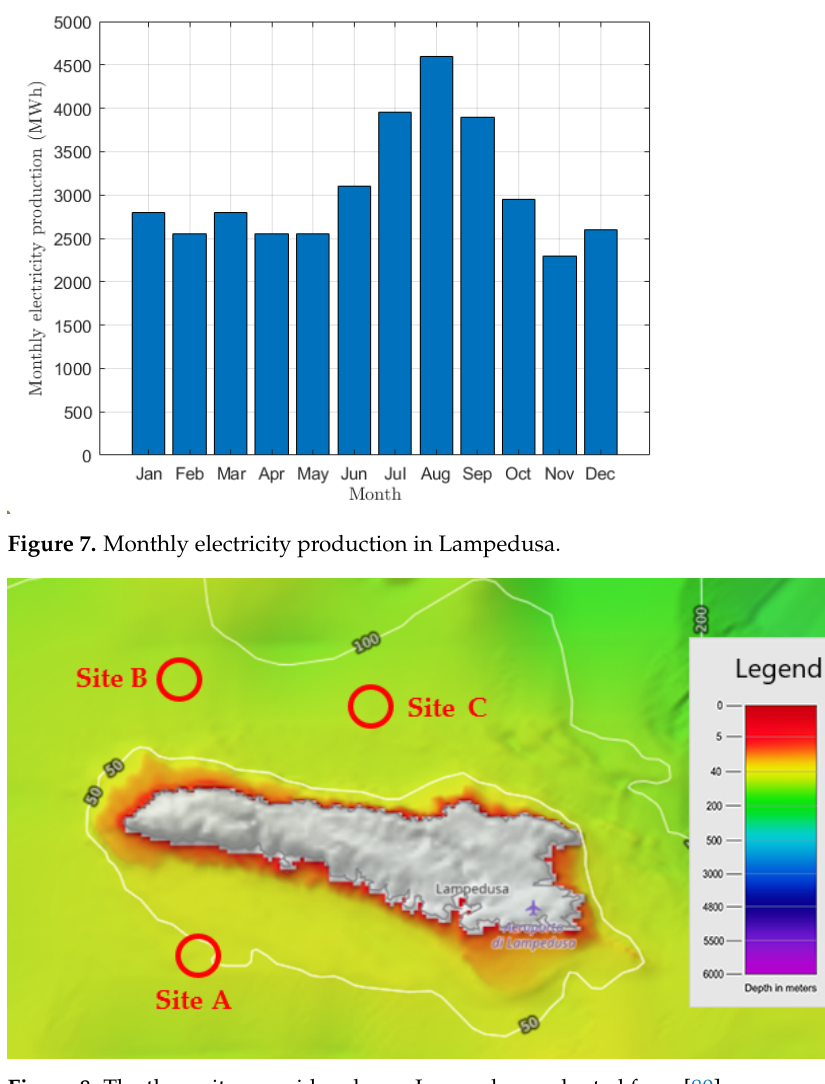
Figure 8. The three sites considered near Lampedusa, adapted from